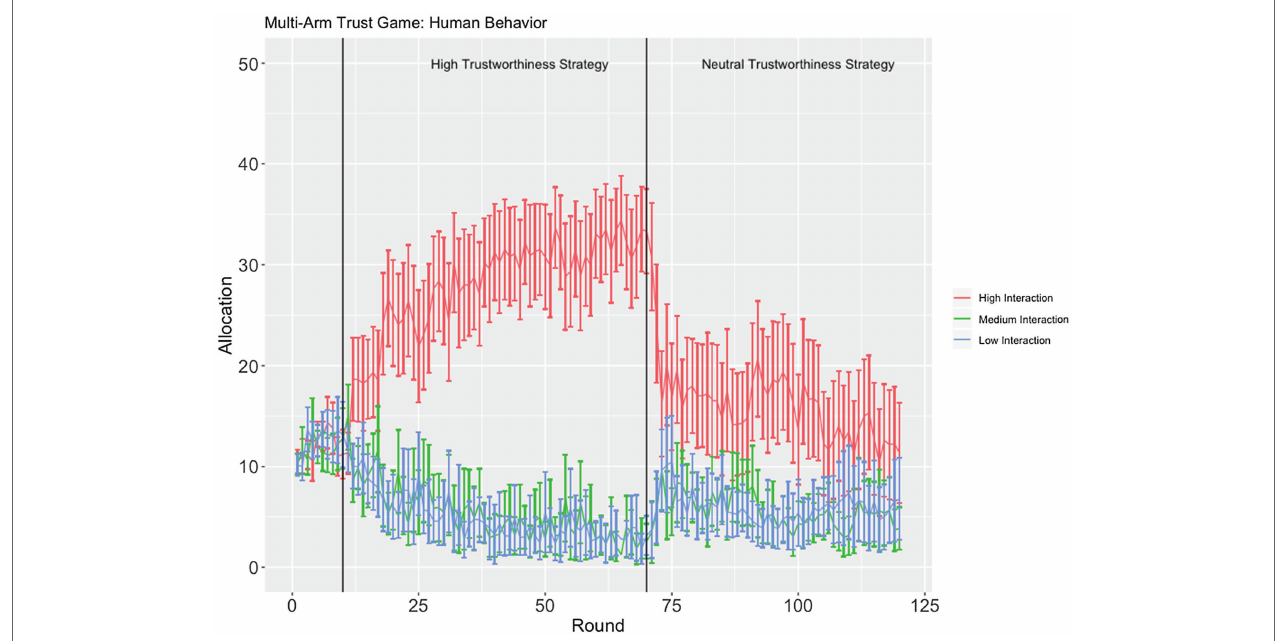
FIGURE 2 | Time course of allocation (proxy for behavioral trust) as a function of interaction schedule, strategy, and round. Error bars are 95% confidence